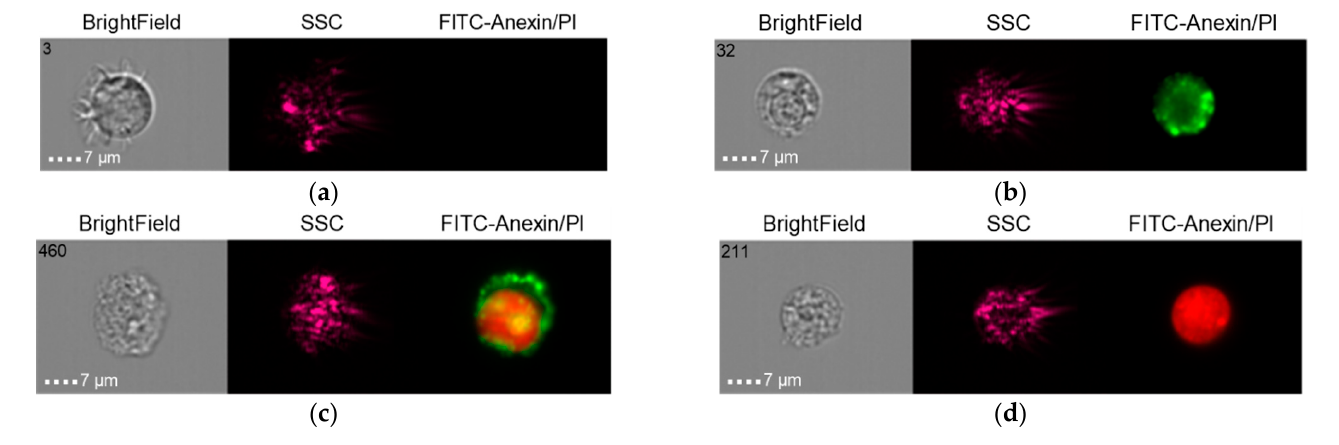
Figure 13. Live cells ( a ), early apoptosis ( b ), late apoptosis ( c ), necrosis ( d ) after co-culture of Alpha Bio NSMP with THP-1 cell line (Alpha Bio NSMP +THP-1).